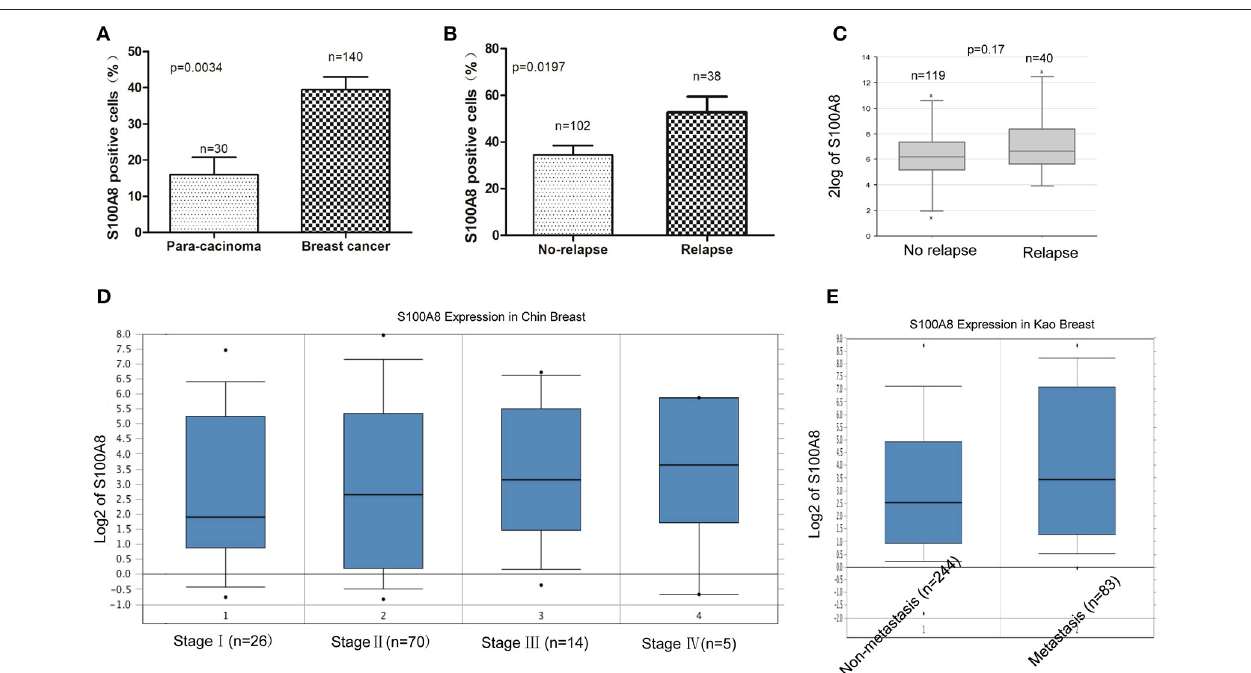
FIGURE 3 | S100A8 is overexpressed in breast cancer tissue. The percentages of S100A8-positive cells in para-carcinoma and breast cancer tissue (A) and in breast cancer tissue without relapse or with relapse (B) . S100A8 gene expression in breast cancer patients without relapse or with relapse was plotted using the R2 online database (C) . S100A8 gene expression in breast cancer patients with different stage (D) or patients without metastasis or with metastasis (E) was plotted using Oncomine database.